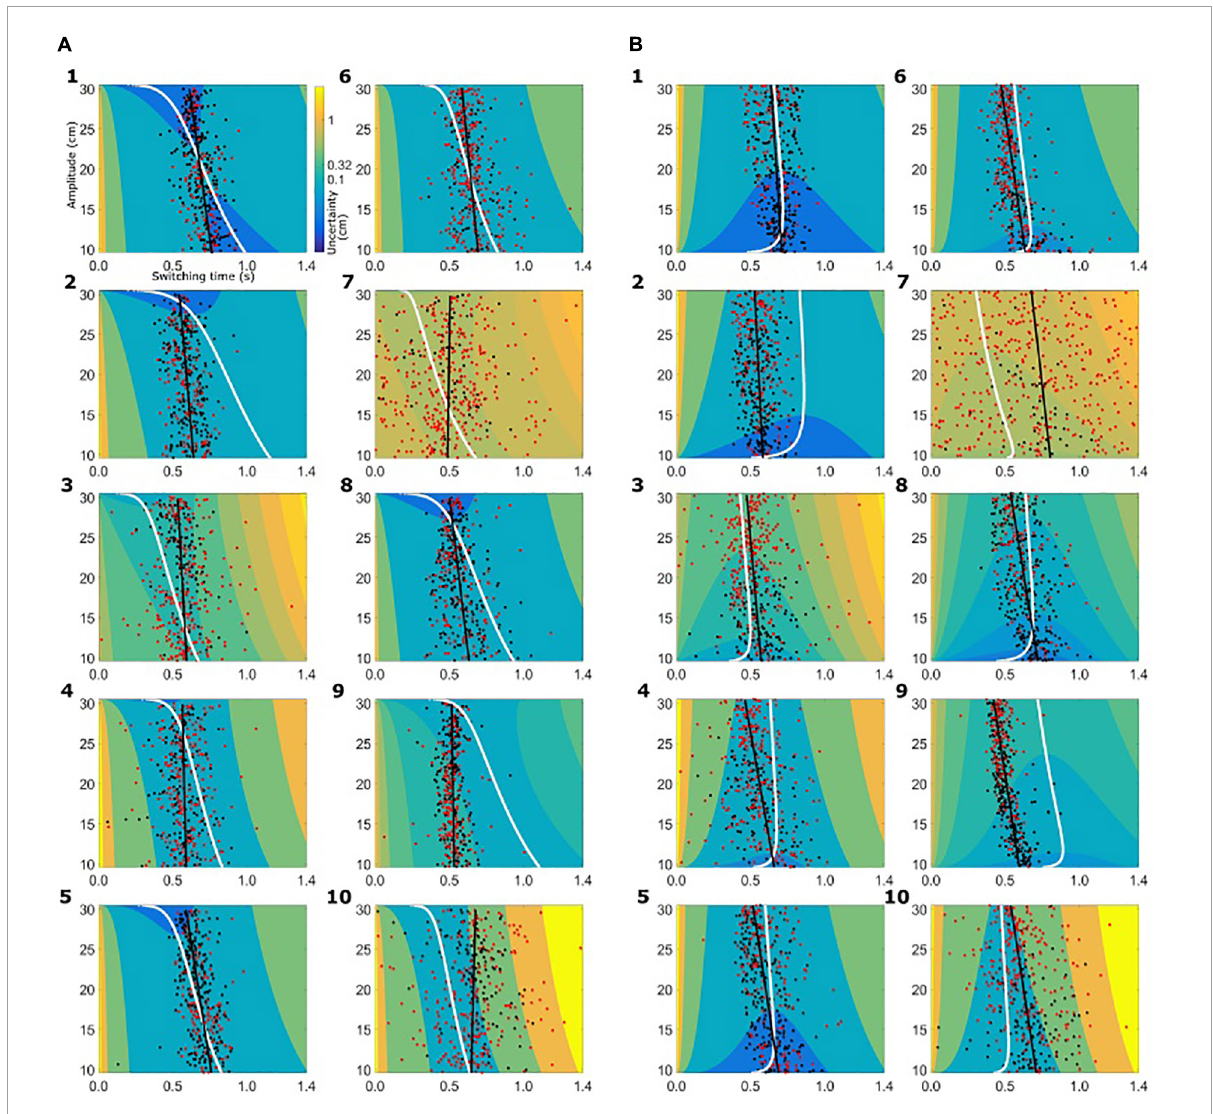
FIGURE5 Sensory-motor uncertainty and switching times for patients. The figure follows the same set-up as Figure 4 . (A) Data from patients for the condition where the ball starts from the left. (B) Data from patients for the condition where the ball starts from the right.